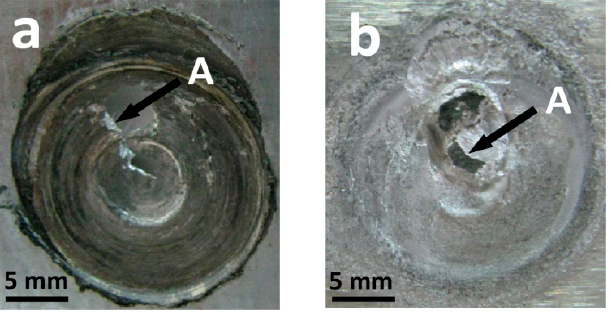
Figure 12. The macro-morphology of tensile fracture surface: ( a ) side of iron; ( b ) side of Mg.